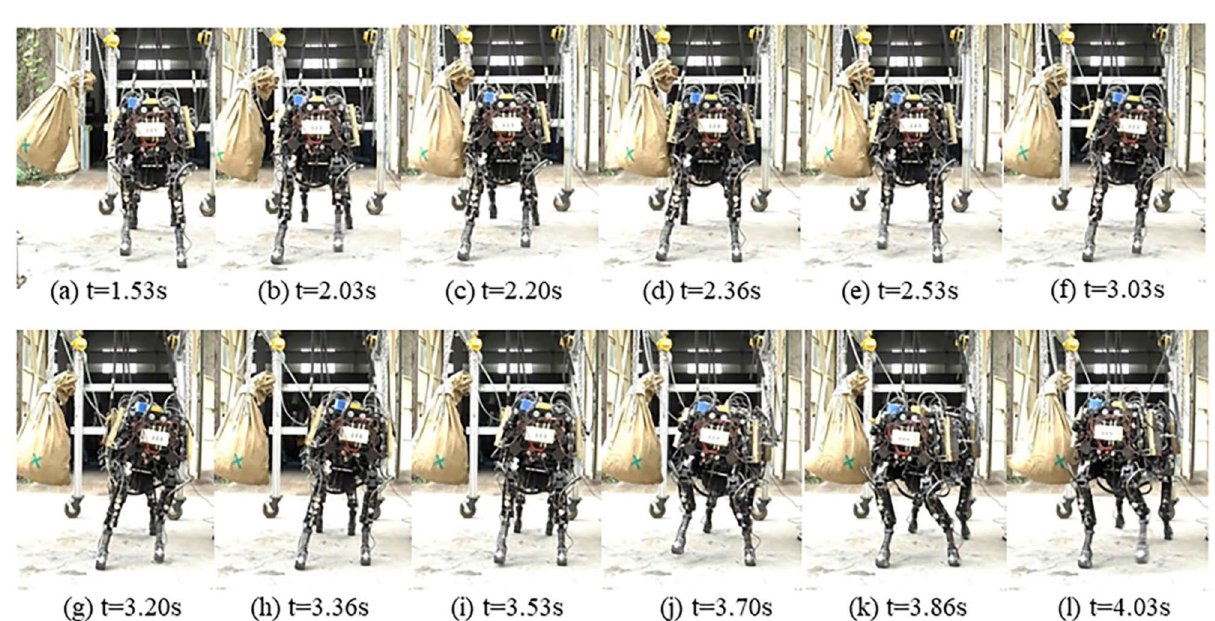
Figure 20. Sequence of photographs showing the complete process of the lateral impact